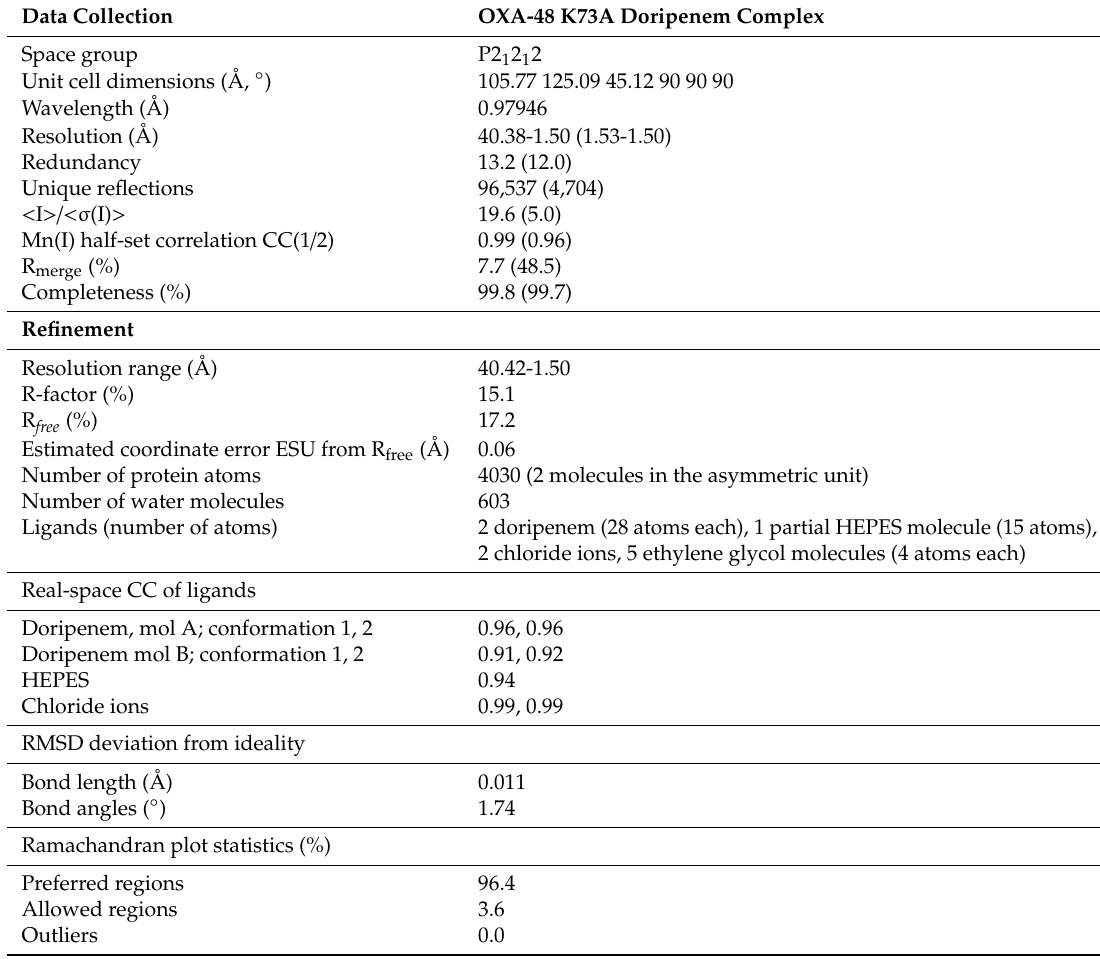
Table 1. Data collection and refinement statistics for the OXA-48 K73A doripenem complex. Data